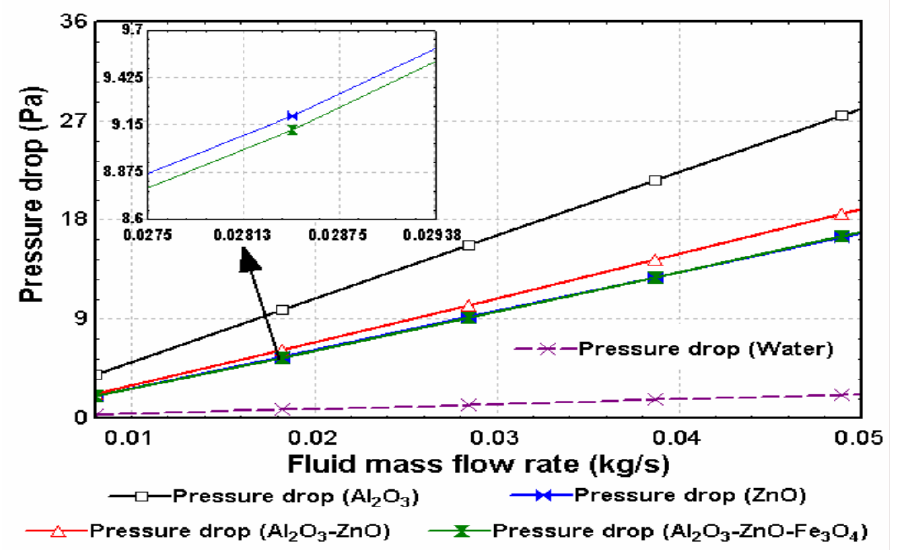
Figure 18. Pressure drop of heat transfer